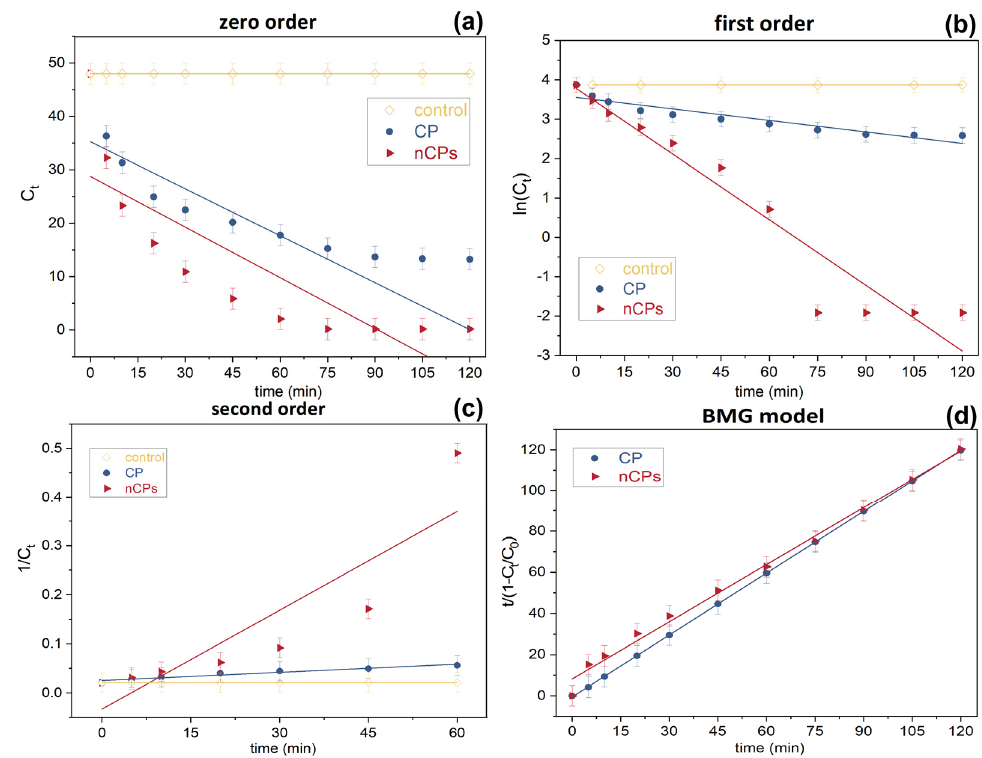
Figure 11. Degradation data of glyphosate using different kinetic models. Table 4. Comparison of kinetic models for different samples (CP and nCPs).